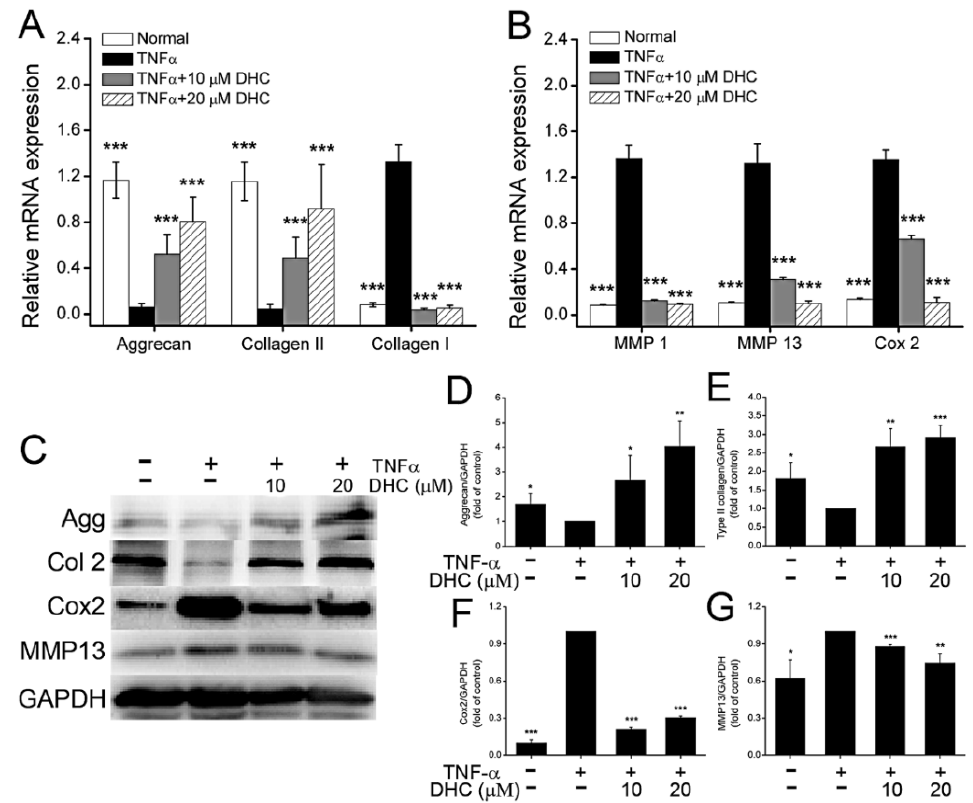
Figure 2. Dehydrocorydaline (DHC) improved the mRNA and protein expression levels of extracellular matrix synthesis (ECM)-relevant genes in the TNF α -treated human chondrocytes at 48 h. Effects of DHC on the mRNA expression levels of ( A ) aggrecan (Agg), type I/II collagen, and ( B ) degrading enzymes such as matrix metalloproteinase 1/13 (MMP1/13) and prostaglandin-endoperoxide synthase 2 (PTGS2, also known as Cox2) in the TNF α -treated human chondrocytes. ( C ) Protein expression levels of Agg, type II collagen, MMP13, and Cox2 in the TNF α -treated human chondrocytes detected through western blotting and ( D – G ) the quantitative results of the bands. Data are presented as mean ± SD. *, p < 0.05; **, p < 0.01; ***, p < 0.001 compared to the TNF α group. Protein expression levels of aggrecan, type II collagen, Cox2, and MMP13 in